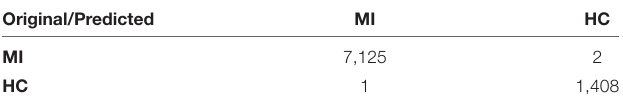
TABLE 3 | Confusion matrix for MI